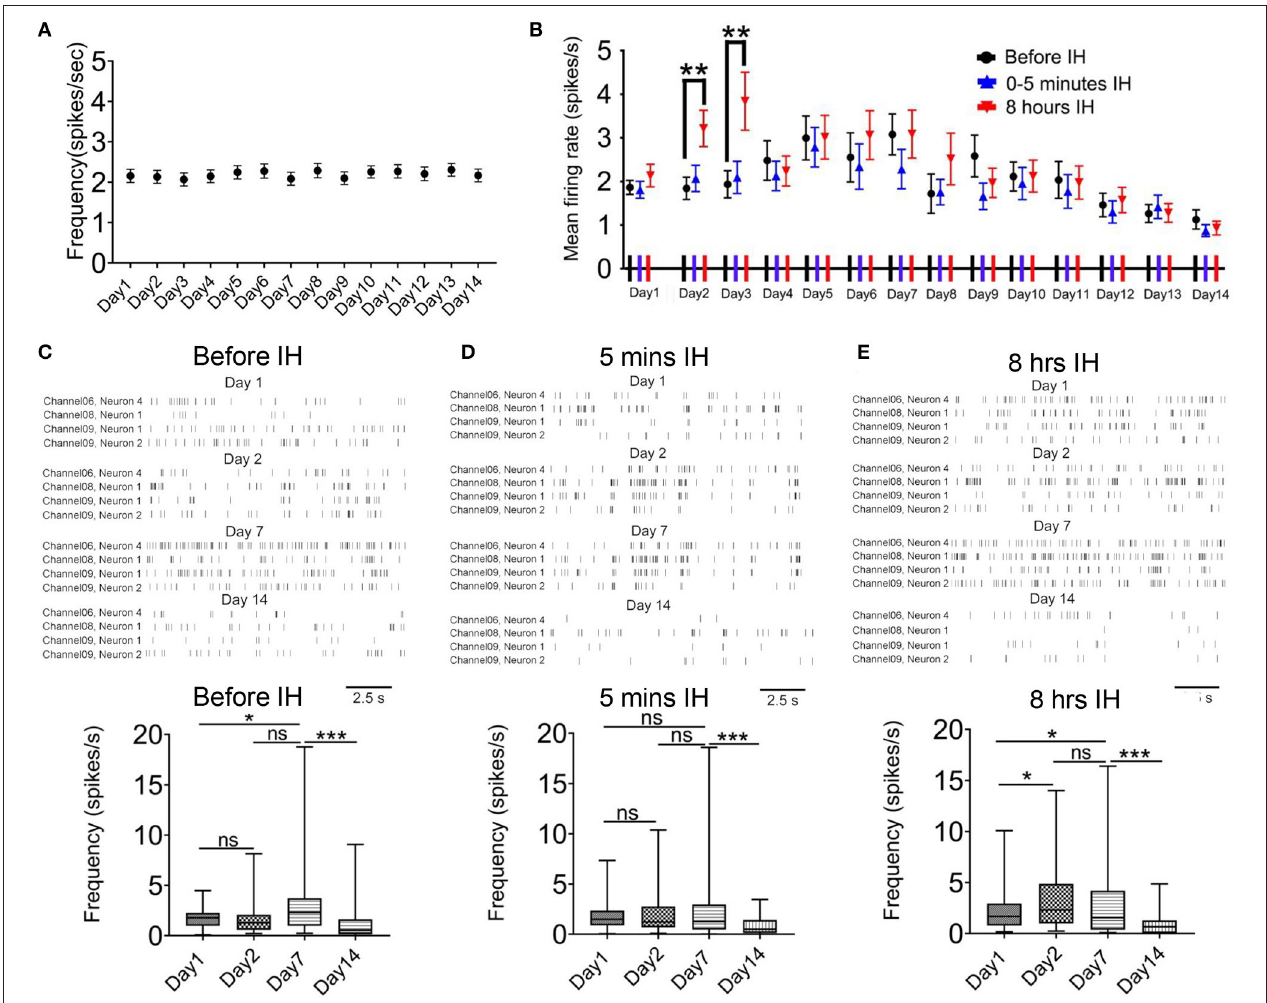
FIGURE 2 | Intermittent hypoxia (IH) exerts complex acute and long-term effects on the firing activities of CA1 putative pyramidal neurons. (A) Repeated measured ANOVA revealed that neuronal firing was not significantly affected in control group which was recorded at about 9:00–9:05a.m. (B) Summary of the mean firing rates of putative pyramidal neurons recorded in the 3 recording sessions in each day over the 2-week period. Putative pyramidal neurons in CA1 region tended to increase their firing activities during the first week of IH treatment, particularly apparent at the late hours (at 8h) but not early hours (at 5min and 3h) of daily IH paradigm. Repeated measured ANOVA revealed that neuronal firing was significantly affected in the 2nd and 3rd day. The hyper-excitability, however, was followed by gradual suppression of firing in the second week. (C) Typical raster plots of the CA1 putative pyramidal neurons recorded before IH on day 1, 2, 7 and 14 (up panel). Statistical results are shown on the bottom. (D) Typical raster plots of the CA1 putative pyramidal neurons recorded in the first 5 IH min of IH treatment on day 1, 2, 7 and 14 are shown on the up and the mean data are summarized on the bottom. (E) Typical raster plots of the CA1 putative pyramidal neurons recorded in the last 5 IH min of IH treatment are shown on the up and the mean data are summarized on the bottom. * P < 0.05, *** P <